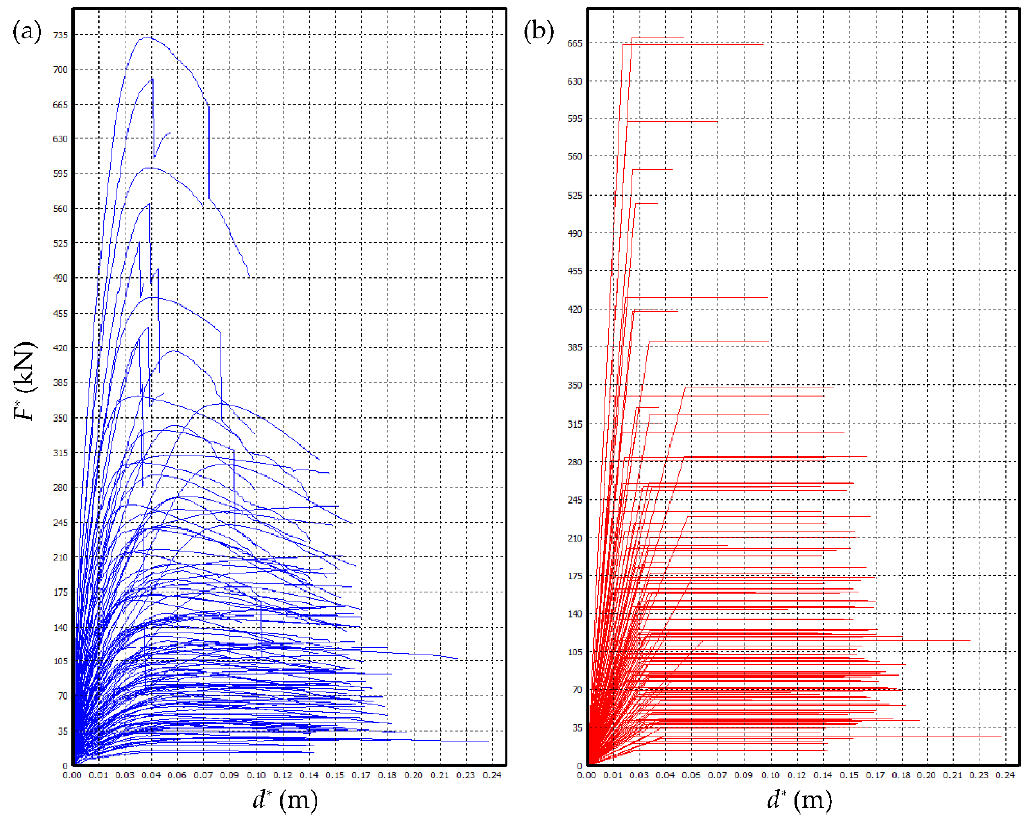
Figure 6. Capacity curves obtained for the ( a ) original structural system ; and ( b ) for the simplified equivalent elastic-perfectly plastic system.